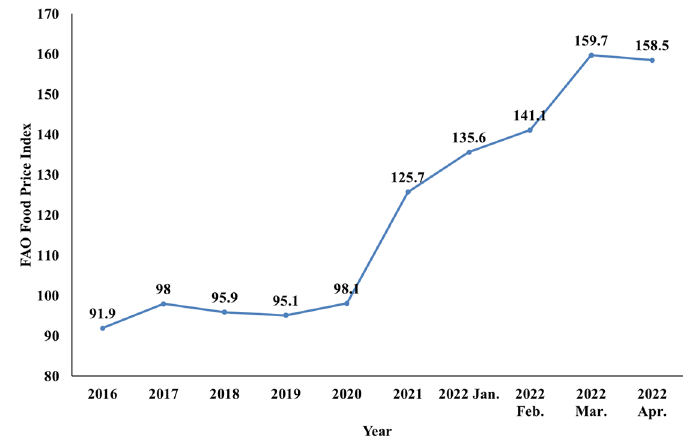
Figure 1. FAO Food Price Index from 2016 to 2022 April.